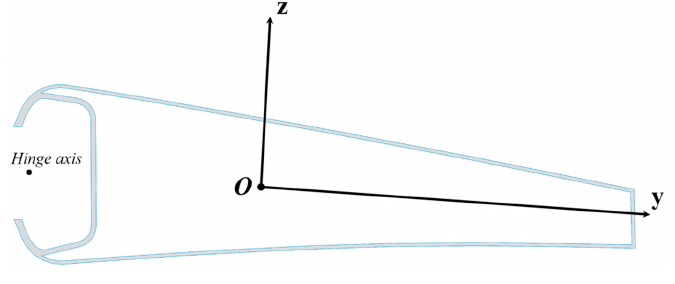
Figure 15. Outer Trailing-edge mean geometric section. Table 2. Data of the Outer Trailing-edge mean geometric section.